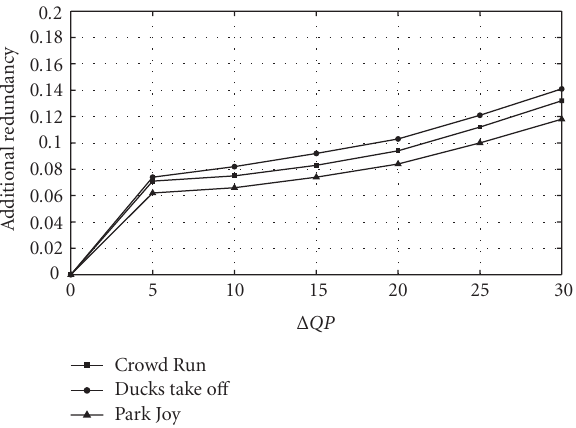
Figure 13: Overhead increase due to ROI introduction for the Park Joy , Ducks take o ff , and Crowd Run video sequences.